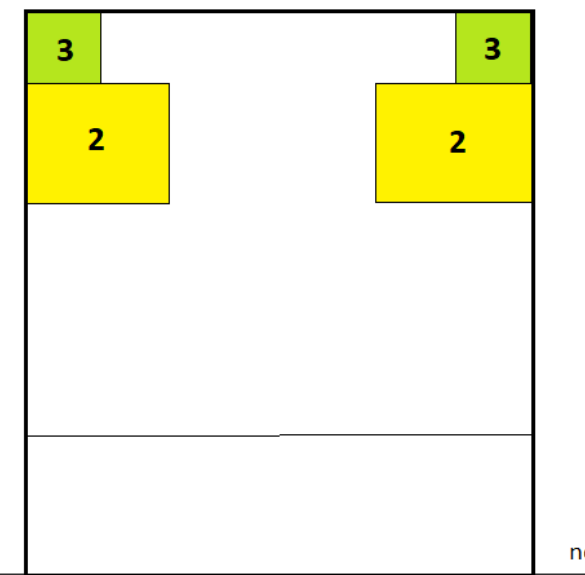
Nutrients 2023 , 15 , x FOR PEER REVIEW